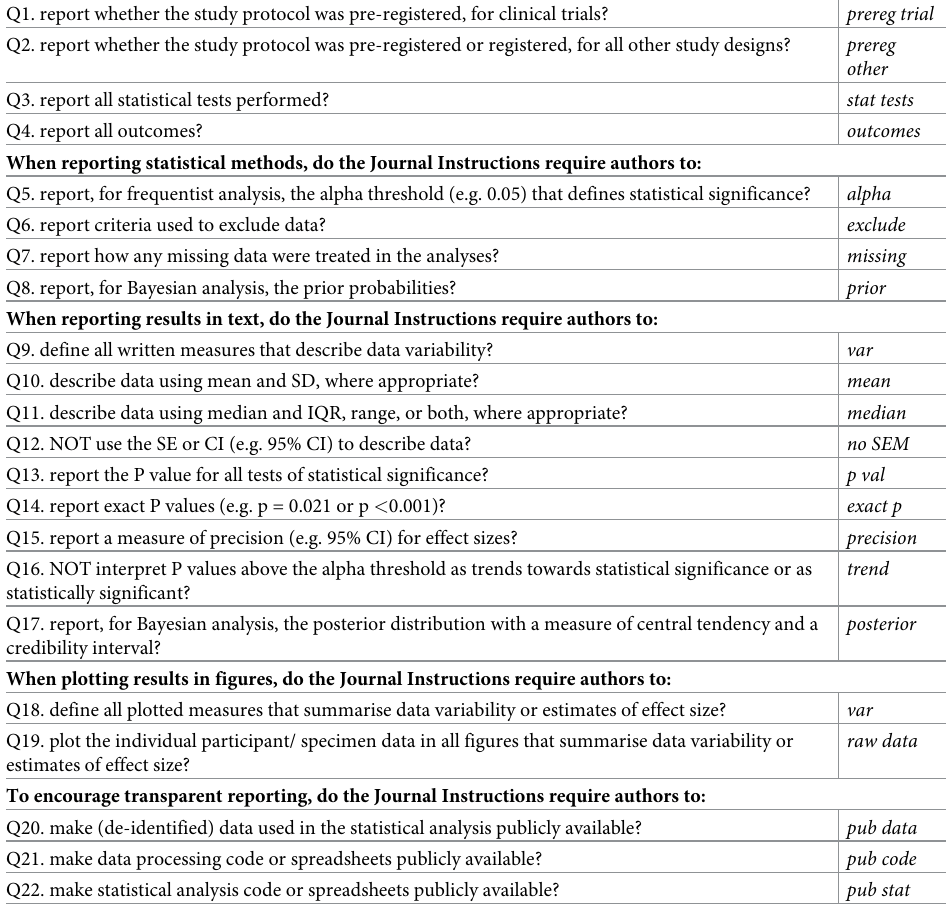
Table 1. Questions to assess how strongly journal Instructions to Authors addressed responsible reporting prac- tices, and variable names (in italics ) used in Fig 1. When reporting research methods, do the Journal Instructions require authors